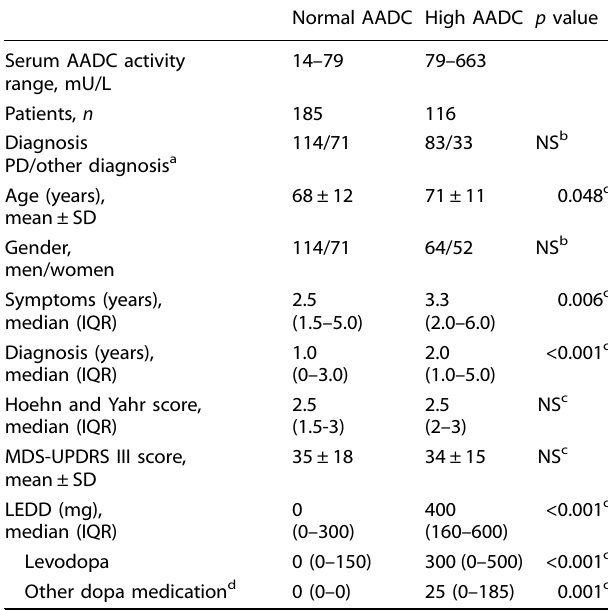
Table 2. Patient characteristics in subgroups with normal and elevated (>79 mU/L) serum AADC enzyme